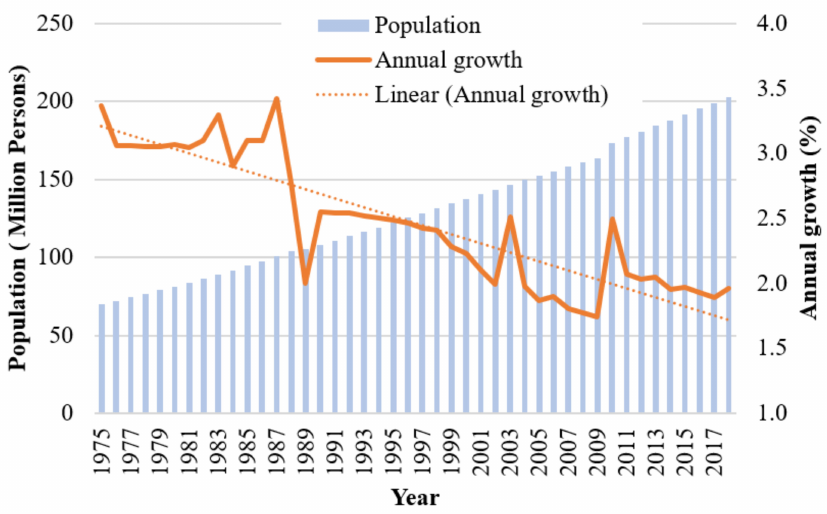
Figure 2. Population growth of Pakistan